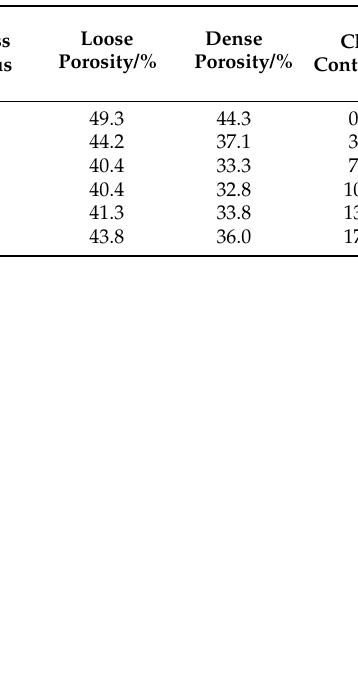
Figure 6. Grading curve of each mixed sand. Range of sand in zone 2 in the figure is the gradation range of mechanism sand in GB/T14684-2011. Table curve in the figure is based on the following formula: 𝐿 𝑖 = 1 − 𝑃 𝑖 = 100 × ( 𝑑 𝑖 , where 𝐿 𝑖 is the accumulated sieve rate, 𝑃 𝑖 is the passing rate, d i is the diameter of each sieve, D is the maximum particle size, and n is the experimental